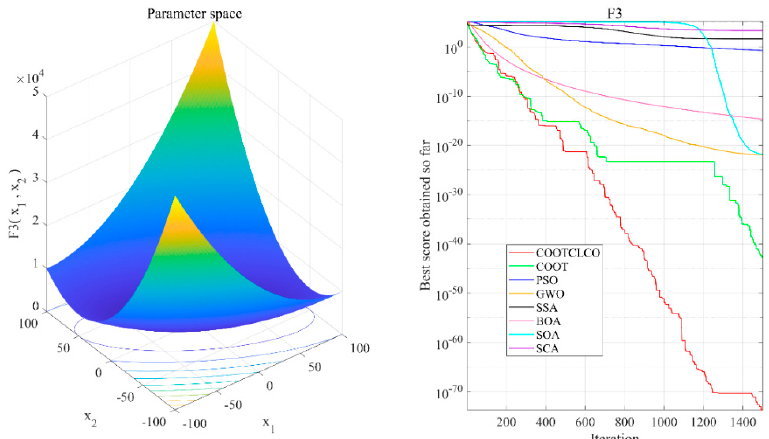
Figure 6. Test function F3 and comparison of convergence curves on F3.